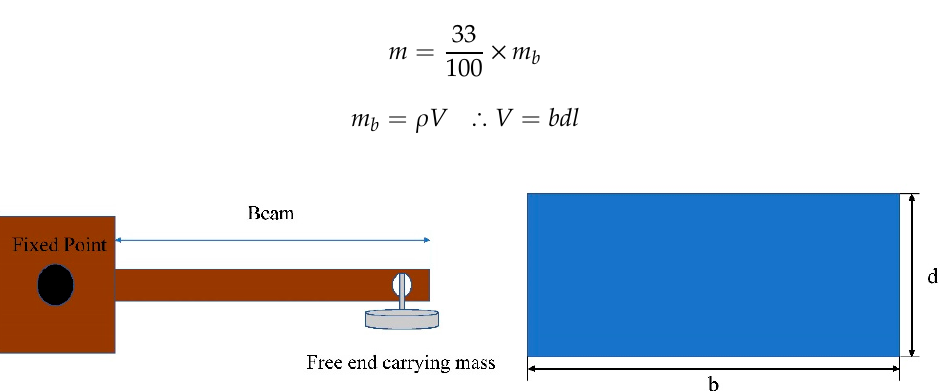
Figure 18. Theoretical relationship between force and displacement.